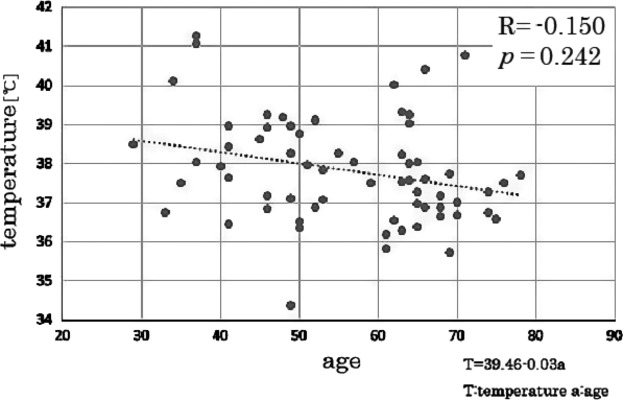
Correlation between age and ventricular CSF temperature in female controls. The dotted line indicates the result of linear fitting. There was no correlation between age and ventricular CSF temperature in female controls controlling for ventricular volume.